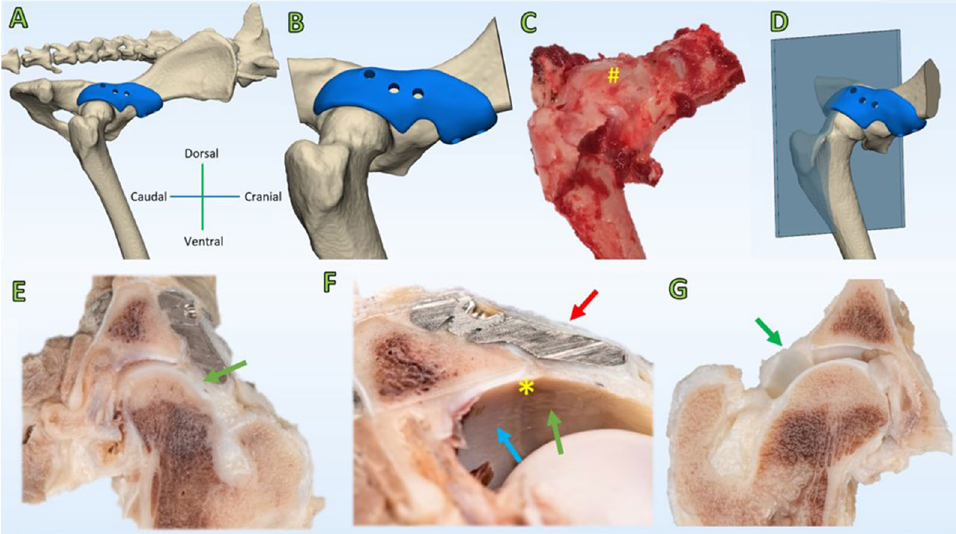
Figure 6. Macroscopy of the intervention and control hip joint of dog#1. ( A ) CT rendering overview of the pelvis with a view on the intervention side. ( B ) CT rendering overview of the size of the dissected specimen. ( C ) Overview of the dissected hip joint with the implant in situ (#). The implant is not distinguishable because it is entirely encapsulated by a thin layer of connective tissue (red arrow, F) . ( D ) CT rendering overview of the cut hip plane (Blue) through the 12.00 o’clock position of the acetabulum. ( E , F ) Cross section through the 12.00 o’clock position of the acetabulum. The joint capsule shows hypertrophy (green arrow, E ) and has incorporated the implant in-between layers (red arrow, F) allowing for a smooth transition (*, F ) from the acetabular cartilage (blue arrow, F ) into the weightbearing hip capsule (green arrow, F ). ( G ) The control hip is depicted for reference in a cross section through the 12.00 o’clock position of the acetabulum. The hip capsule has a minimal thickness (green arrow, G ) as compared to the intervention side (green arrows, E , F